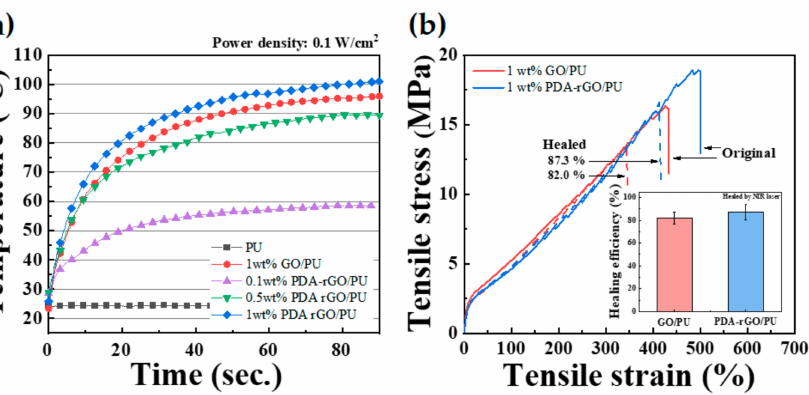
Figure 7. ( a ) Change in surface temperature during NIR light irradiation at a power density of 0.1 W/cm 2 and ( b ) strain–stress curves for original and healed of 1 wt% GO/PU and 1 wt% PDA– rGO/PU nanocomposites. Self-healing efficiency